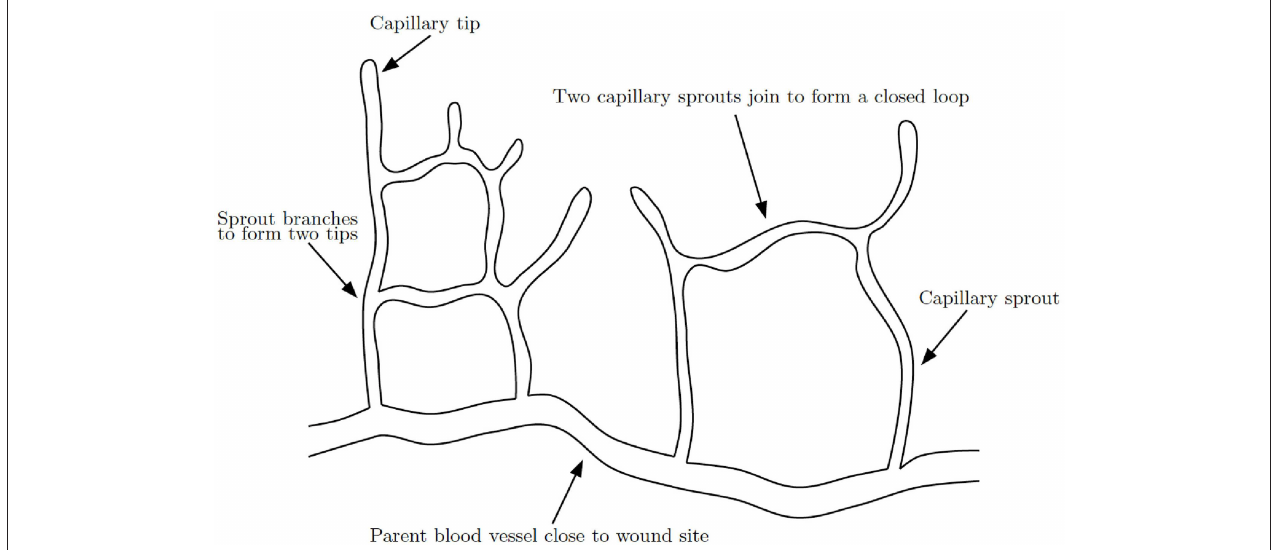
FIGURE 4 | Schematic of capillary network formation. Sprouts branch and join to form a closed network of capillaries, modified from Gaffney et al. (2002).